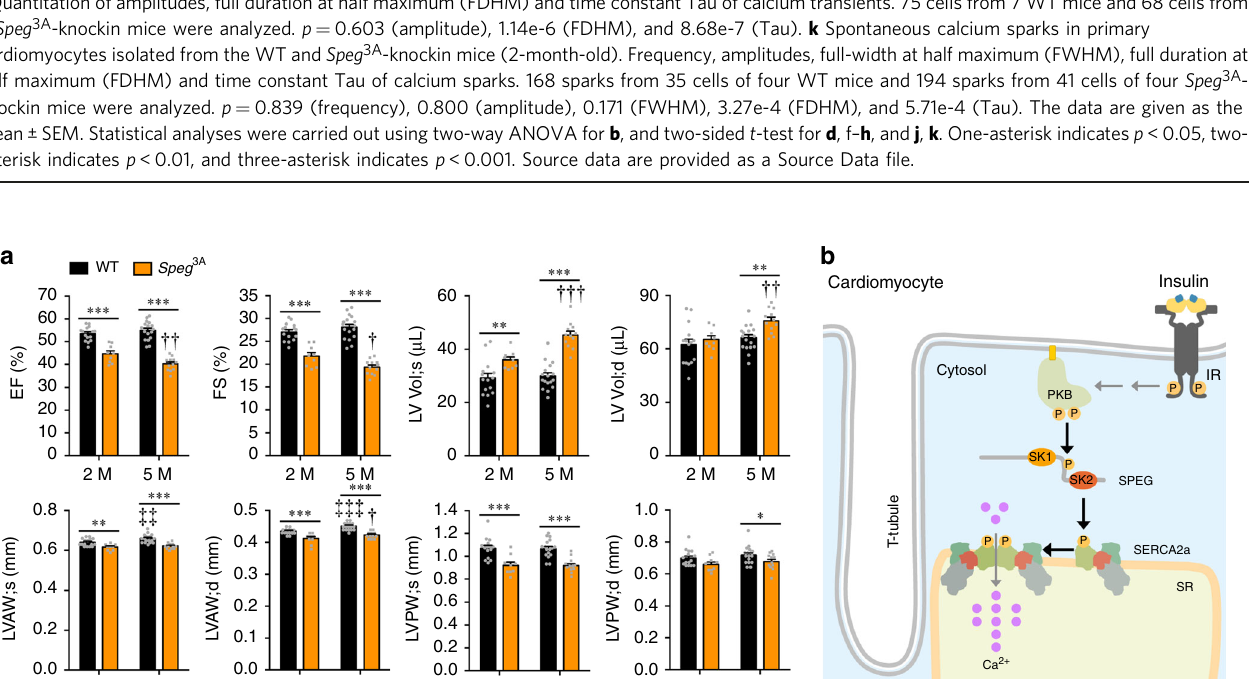
Fig. 8 Calcium homeostasis in Speg 3A -knockin cardiomyocytes. a , b Phosphorylation of PKB, SPEG, and SERCA2a in WT or Speg 3A primary cardiomyocytes stimulated with or without insulin. Phosphorylation of PKB, SPEG and SERCA2a was normalized with their respective total proteins, and quantitative data were shown in b . n = 6. One-dagger (WT insulin vs Speg 3A insulin) indicates p < 0.001. c , d Thr 484 phosphorylation of SERCA2a in the heart of Speg 3A mice and WT littermates (7-month-old). c representative blots. d quantitation of SERCA2a-Thr 484 phosphorylation. n = 10 (WT) and 8 ( Speg 3A ). p = 2.81e-3. e , f . Oligomerization of SERCA2a in the heart of Speg 3A mice and WT littermates (7-month-old). e representative blots. f quantitation data. n = 12. p = 1.97e-2. G-H. SERCA2a Ca 2 + -transporting activity ( n = 15 (WT) and 14 ( Speg 3A ), g ) and ATPase activity ( n = 4, h ) in microsomes isolated